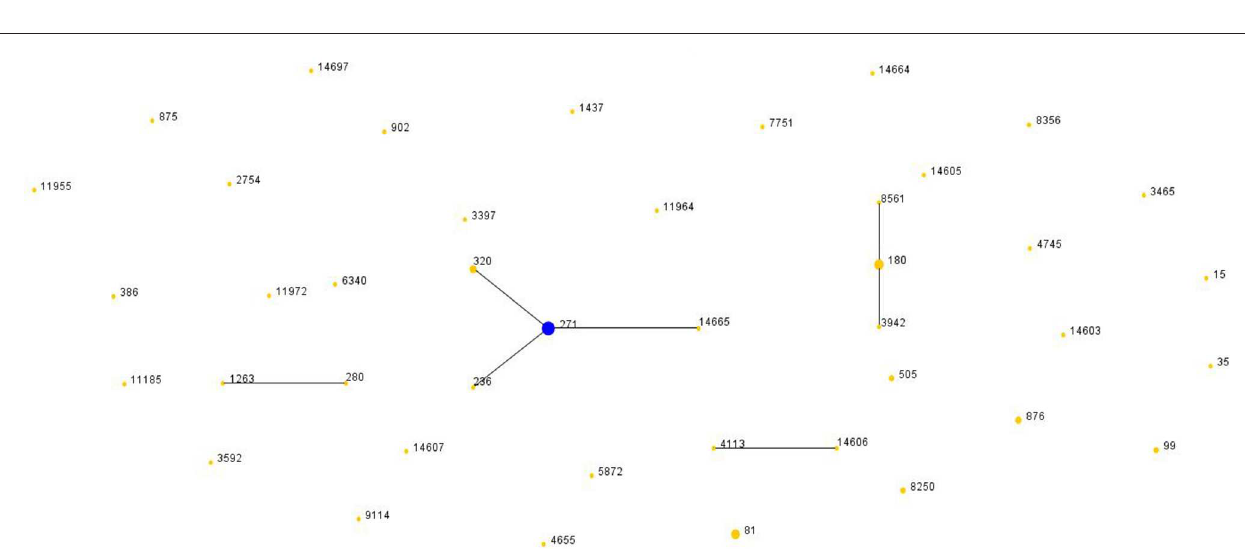
FIGURE 3 | Population snapshot of S. pneumoniae. The STs were displayed as a single eBURST diagram by setting the group definition of zero of seven shared alleles. Each number represents one ST and the area of each circle indicates the prevalence of the ST in the MLST data of this study. All 44 STs were shown here in only one group. MLST, Multilocus sequence typing; ST, Sequence